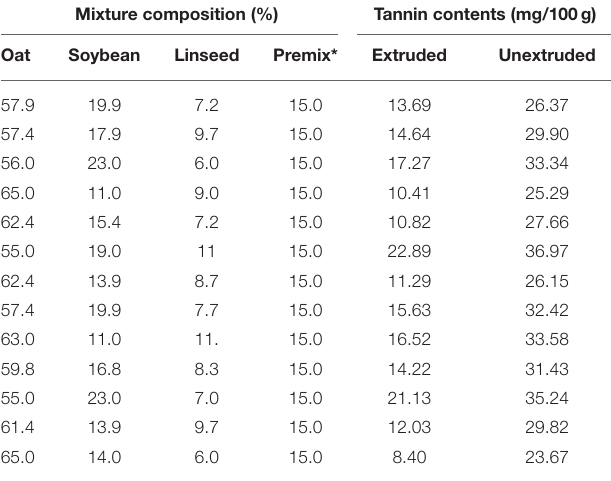
TABLE 3 | Paired t -test of phytate contents of unextruded and extruded composite flour. N Mean StDev SE mean Phytate unextruded 13 188.31 178.33